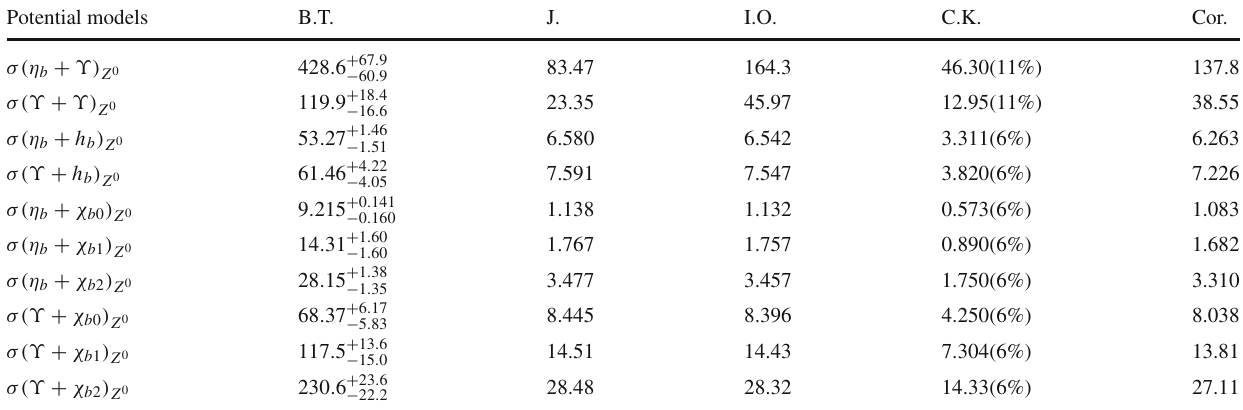
√ s = m Z . The percentages in brackets are the ratios of the maximum or minimum in other potential models to the estimates under the B.T. model